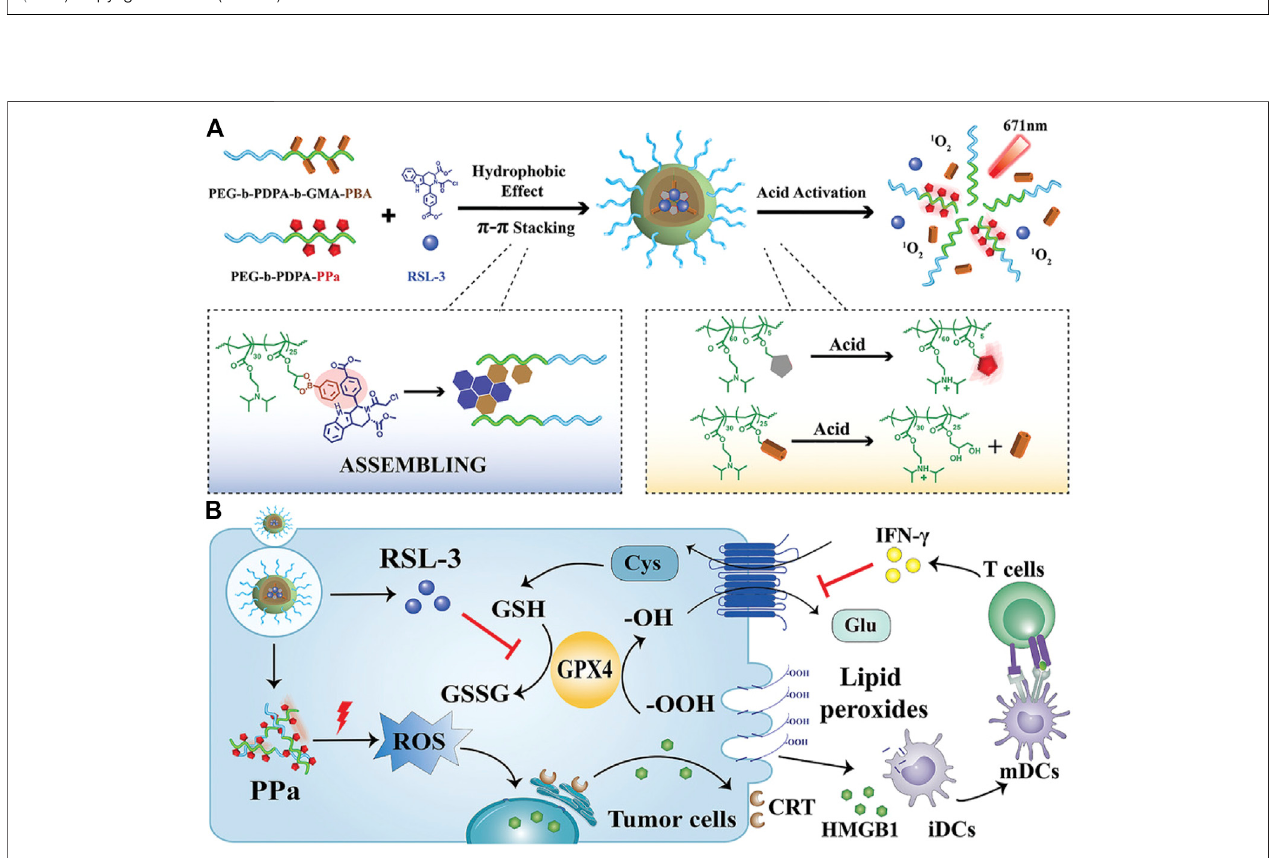
FIGURE 14 | (A) Synthesis scheme of NPs. (B) Schematic illustration of the mechanism. Adapted from Song et al., (2021) Copyright @ 2021 (Wiley).